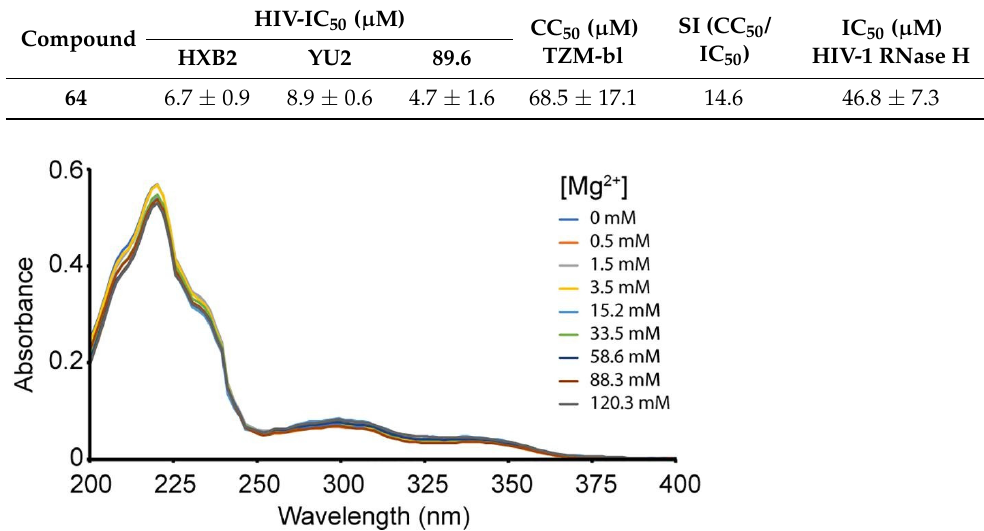
Figure 14. UV absorbance spectra of compound 64 with different concentrations of Mg 2+ ion [55]. Table 9. The inhibitory activity of compound 64 against different HIV strains and HIV-1 RNase H. Compound